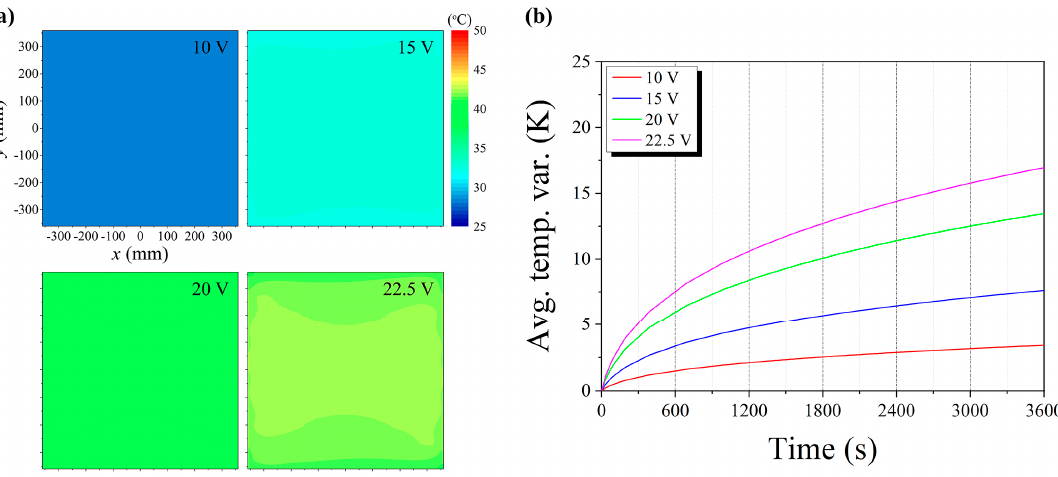
Figure 3. Numerical simulation results of the thermal responses of the portable and large-area blackbody system: ( a ) temperature distributions on the black surface; ( b ) transient profiles of the average temperature variations.